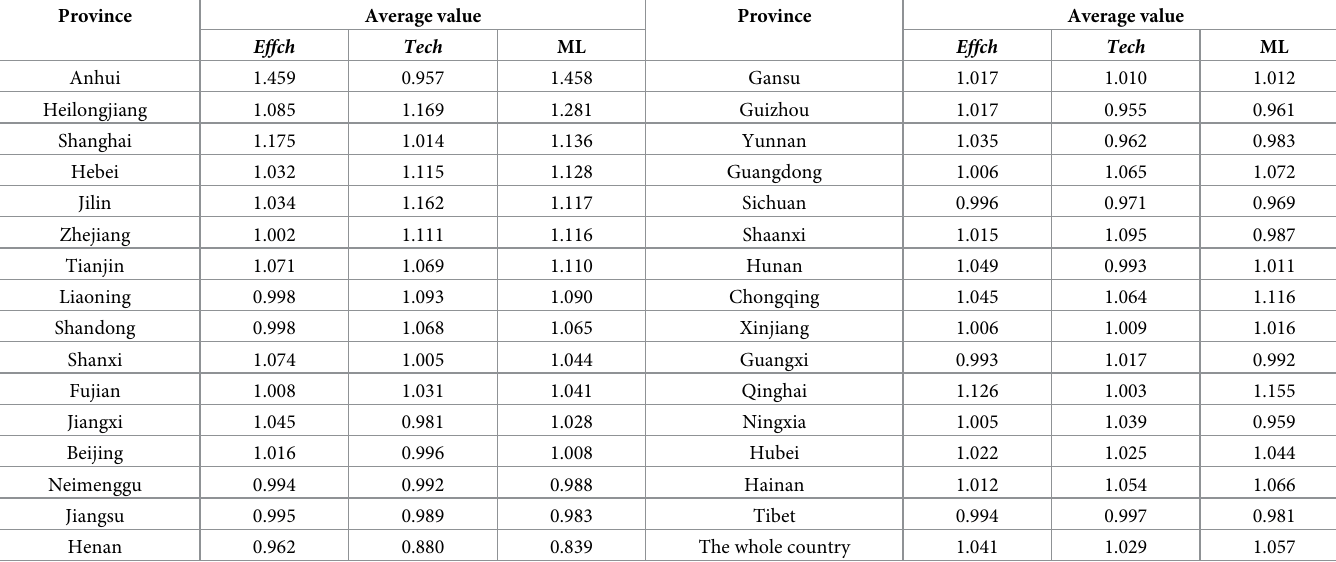
Table 3. Average values of ML index, Effch index and Tech index of 31 provinces.